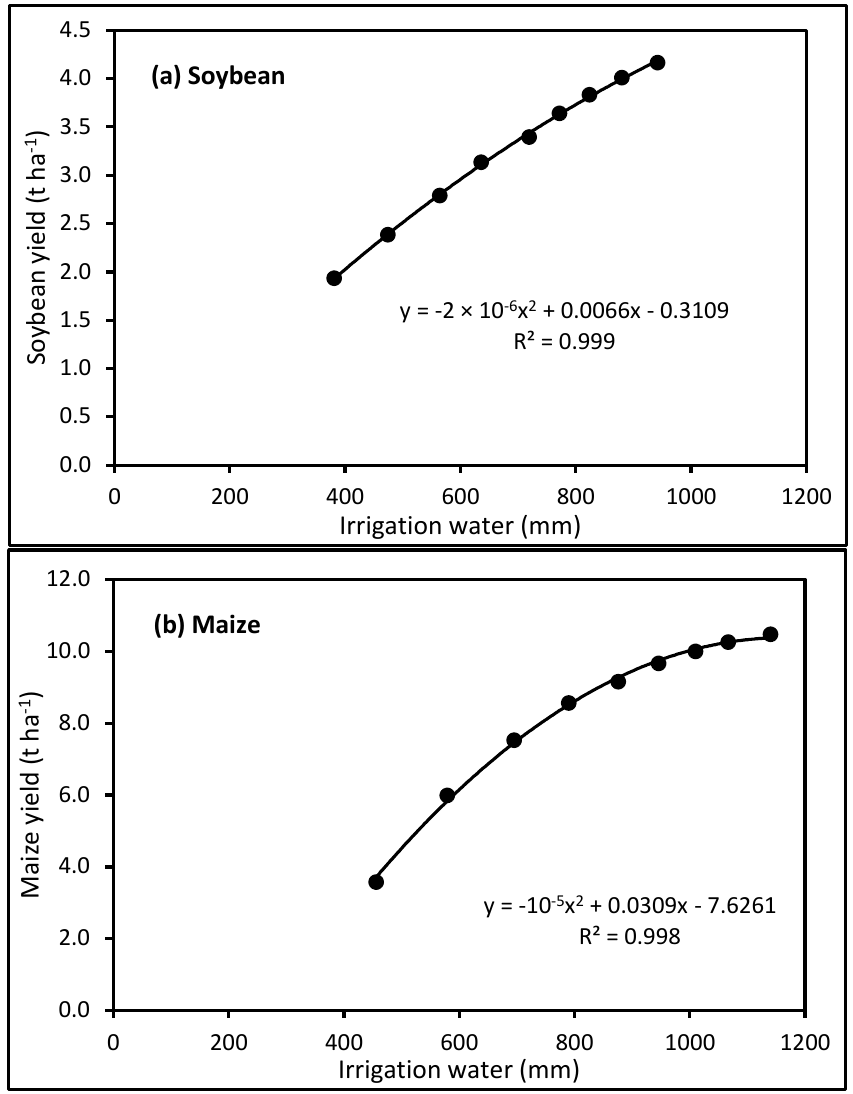
Figure 5. Simulated water production function of soybean and maize and fitted polynomial function in the Riverina region of NSW, Australia.